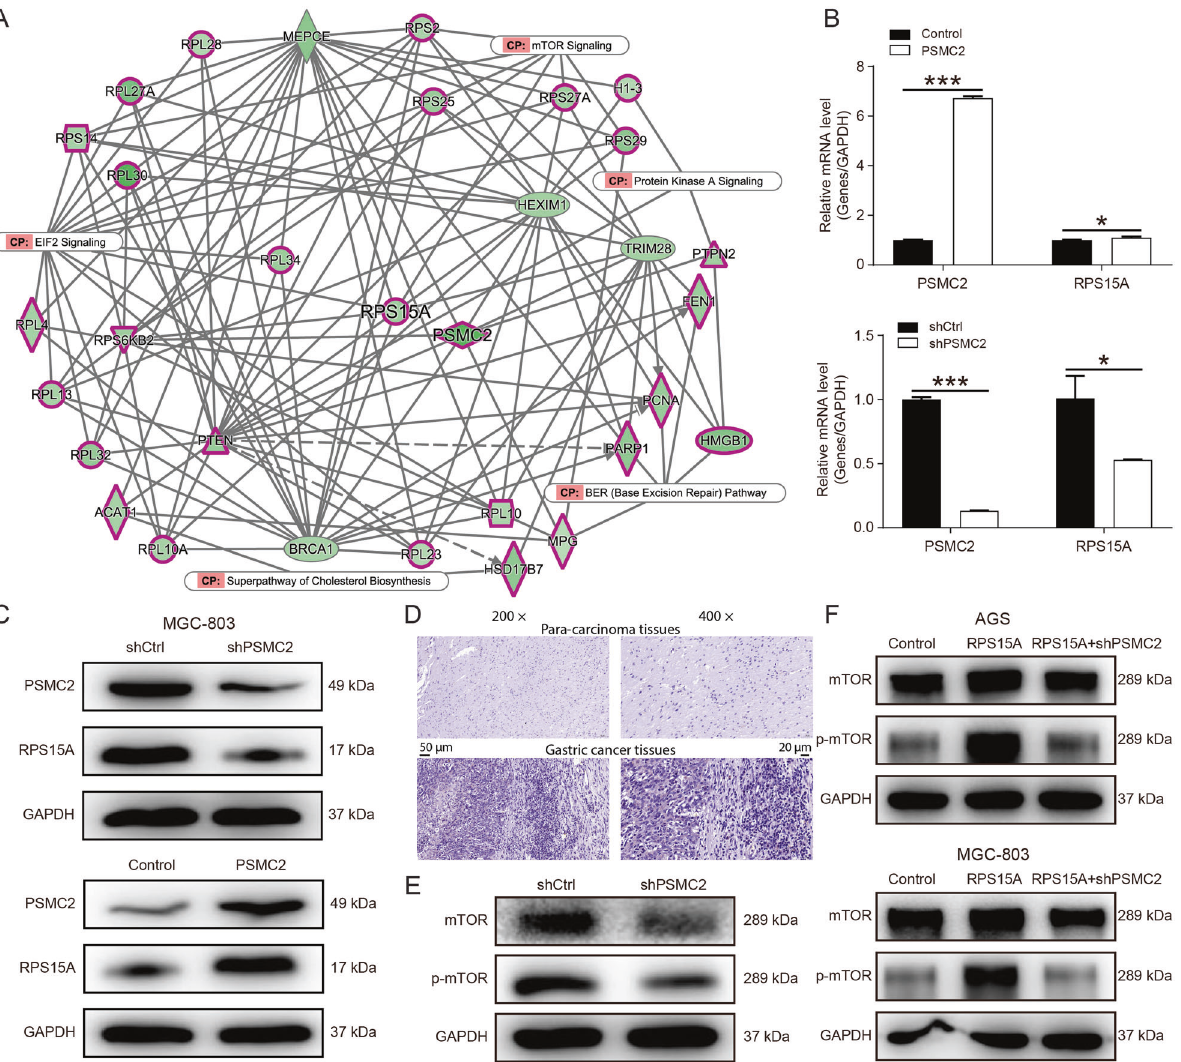
Fig. 3 PSMC2 activated mTOR pathway by upregulating RPS15A. A IPA was employed to map the interaction network between molecules and pathways signi fi cantly related to PSMC2. B qPCR was conducted to measure the levels of PSMC2 and RPS15A mRNA in MGC-803 cells after PSMC2 overexpression or knockdown. C WB was performed to measure the levels of PSMC2 and RPS15A proteins in MGC-803 cells after PSMC2 overexpression or knockdown. D Immumohistochemical staining was conducted to evaluate the expression of RPS15A in the gastric cancer tissues and para-carcinoma tissues. E WB was employed to detect the expression of mTOR pathway-related proteins after PSMC2 knockdown. F The expression of mTOR pathway-related proteins in MGC-803 cells with RPS15A overexpression or RPS15A overexpression and PSMC2 knockdown. * P < 0.05, *** P < 0.001, compared with Control group. Error bars meant